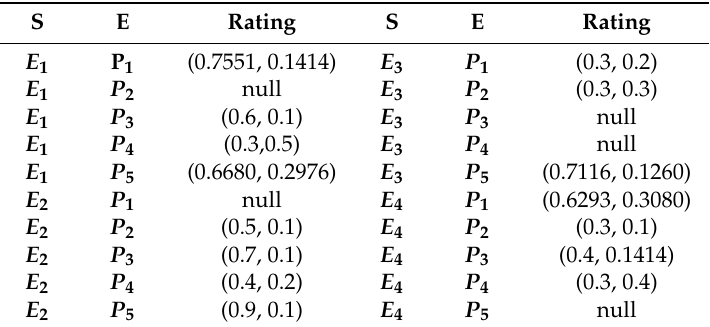
Table 2. Rating matrix after